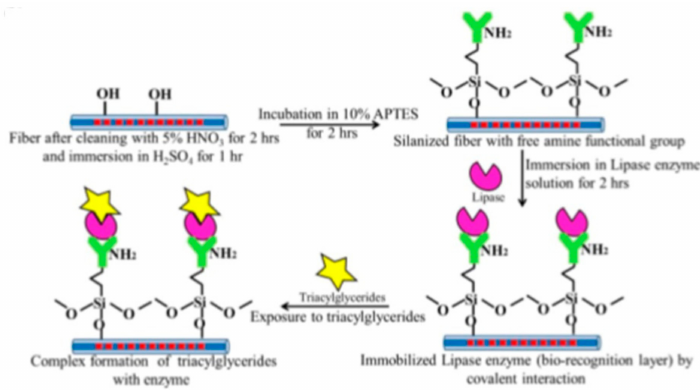
Figure 38. Schematic diagram of the layer-by-layer modification of